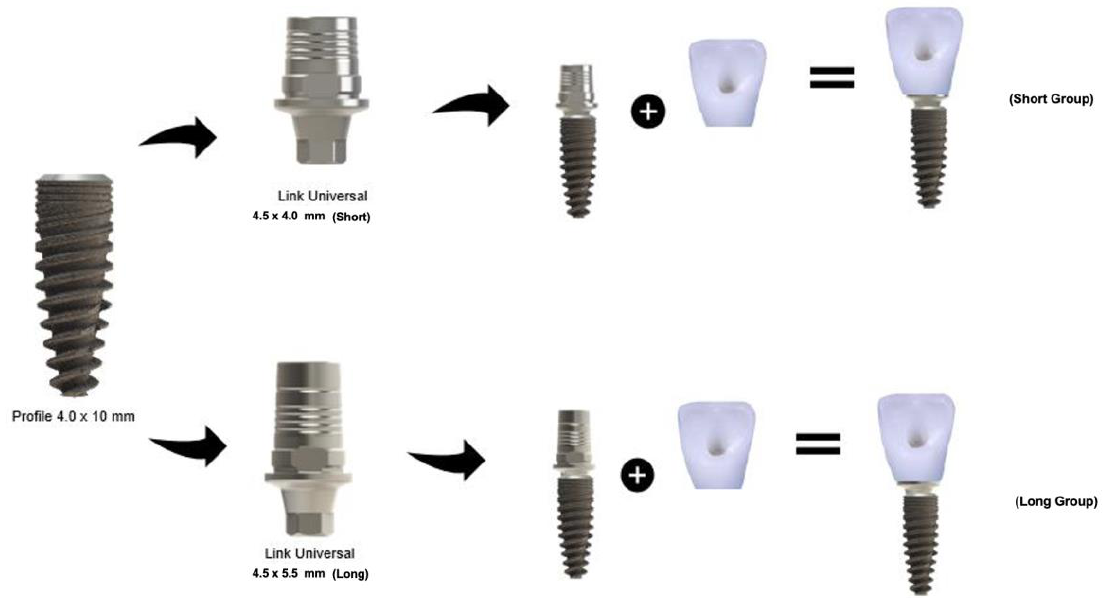
Figure 1. Schematic sequence of the composition of the two experimental groups. For the substrate preparation, the polyurethane resin was manipulated with equal measures of a base and catalyst until it reached complete homogenization. The resin was poured into the PVC tubes under 45 lbs of pressure in a vacuum pressurizer (Protecni, Araraquara, SP, Brazil) to avoid incorporation of bubbles. After the resin polymerization, the surfaces were smoothed with SiC sandpaper (#220, #320, #400, and #600) under constant irrigation using an automatic polisher (Ecomet/Automet 250, Buehler, IL, USA) to remove the surface irregularities. A surgical kit (Profile, Titaniumfix, S ã o Jos é dos Campos, SP, Brazil) was used to prepare the perforations in each block. All implants were placed according to the manufacturer’s recommendations, with a torque of 35 N.cm, as per ISO for dental implant fatigue (ISO 14801:2016) [31] (Figure 2).